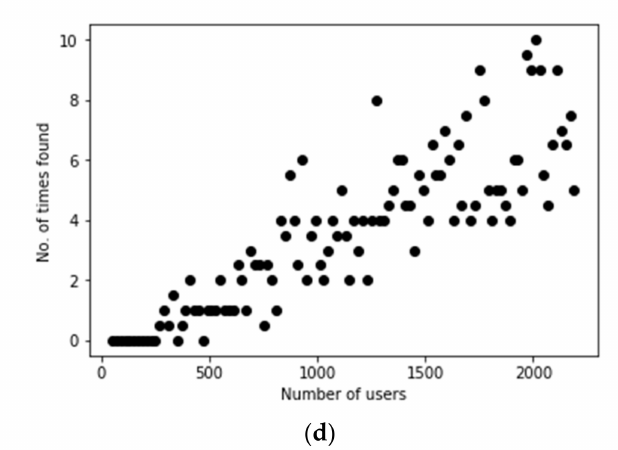
Figure 4. ( a ) Screenshot from the simulation for the Athens centre with the missing child (red dot) and 600 users (blue dots) ( b ), ( c ), ( d ) Results of simulation runs: ( b ) median value for the days needed for the missing child to be found, removing outliers using a z-score with a ± 3 standard deviations threshold. ( c ) Simulation results using boxplots for nb_people mod 50 = 0. ( d ) Median value for the number of times the missing child is found in a 2-day simulation for different numbers of